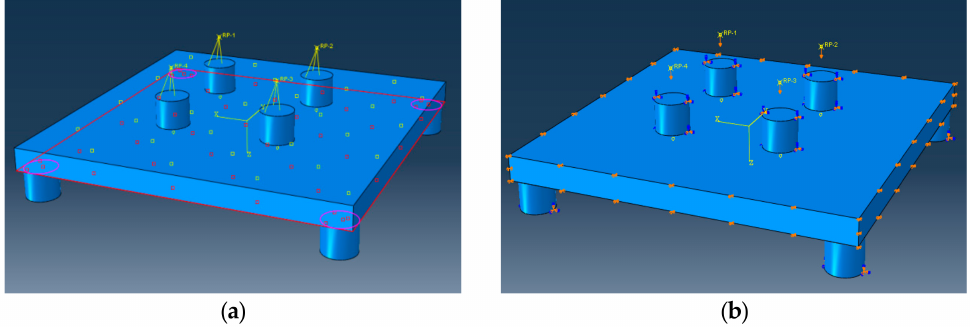
Figure 17. Boundary condition as defined. ( a ) Definition of contact relationships; ( b ) Applied